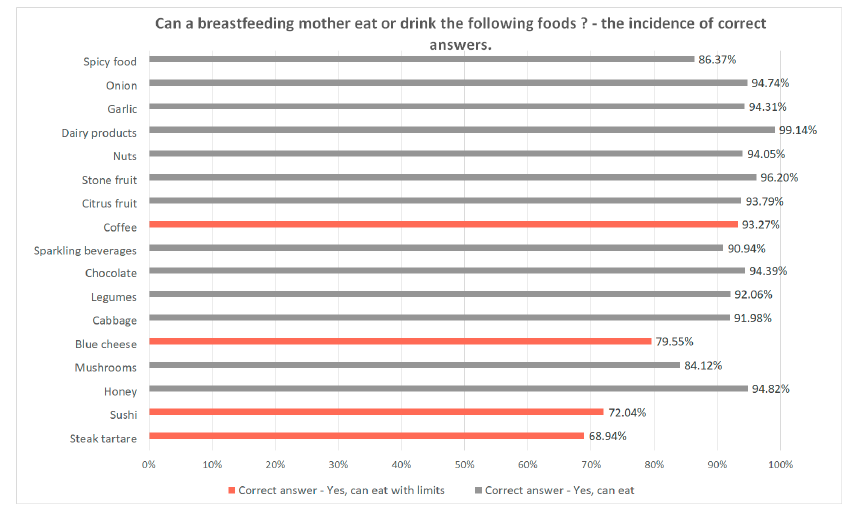
Figure 2. Can a lactating mother eat or drink the following products: incidence of correct answers for each of the 17 products included in the questionnaire. The bars on the chart referring to foods that can be eaten with limits are colored orange, and the bars referring to foods that do not need any prophylactic restriction are colored gray.